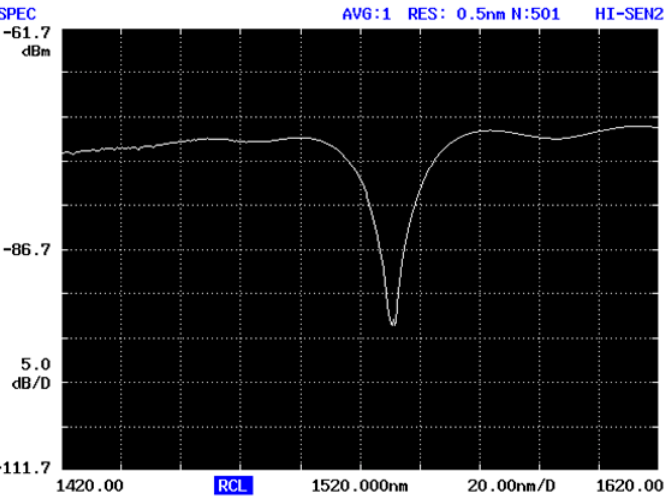
Figure 2. Transmission spectrum of LPFG filter.